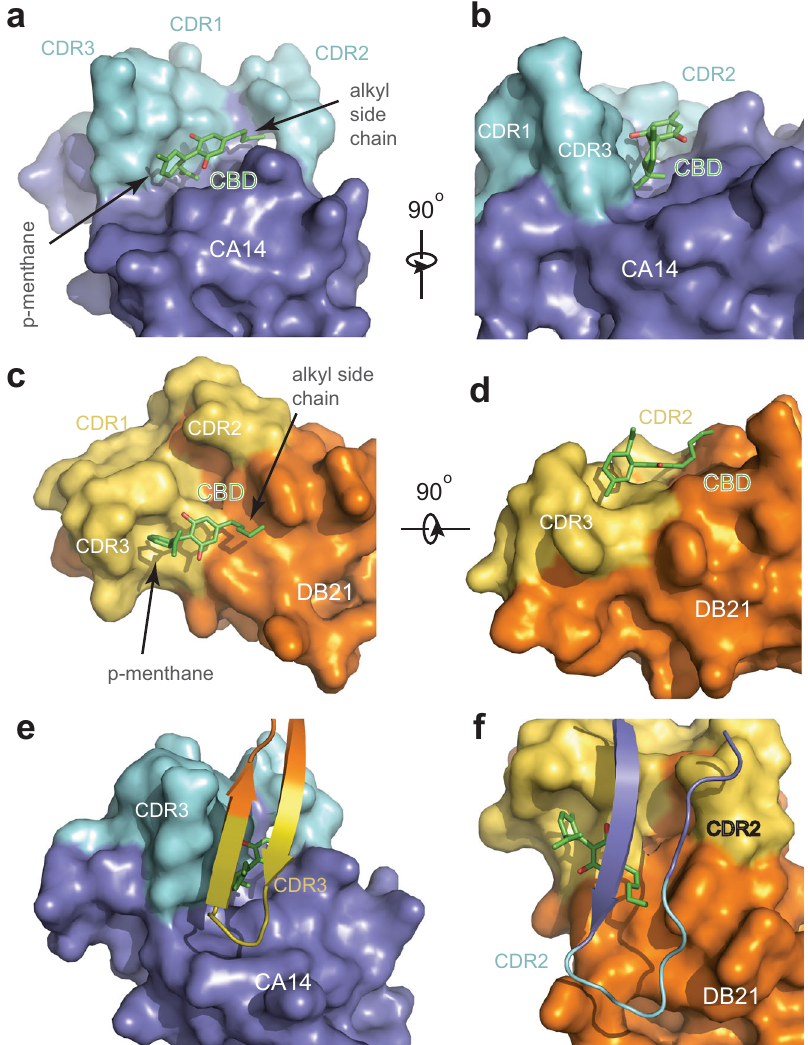
Fig. 2 Intermolecular interfaces among CBD, CA14, and DB21. a , b Two orthogonal close-up views of the interface between CBD and CA14. CBD is shown in green and red sticks. CA14 is shown in dark blue surface representation except for three complementarity determining regions (CDRs) highlighted in cyan. c , d Two orthogonal close-up views of the interface between CBD and DB21. DB21 is shown in orange surface representation except for three CDRs highlighted in yellow. e , f Two close-up views of the interface between CA14 and DB21 with CBD sandwiched in the middle. A CDR and its nearby region of a nanobody (shown in cartoon model) directly pack against their equivalent parts in the other nanobody (shown in surface